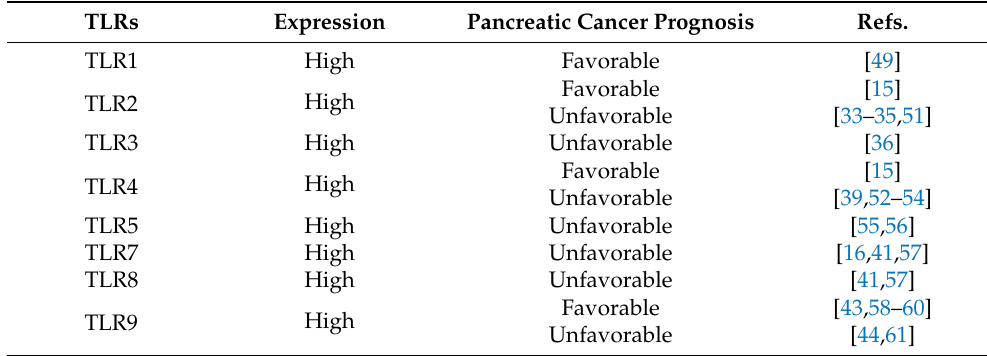
Table 2. Association between TLRs expression and pancreatic cancer prognosis. TLRs Expression Pancreatic Cancer Prognosis